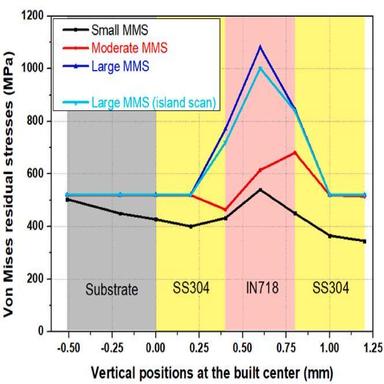
Residual Von Mises stresses along the building direction in the center of the MMS builds (Fig. 16a).